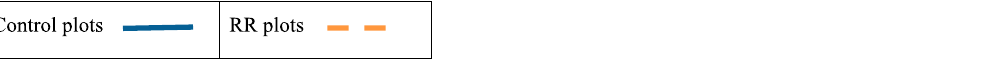
Frontiers in Environmental Science |